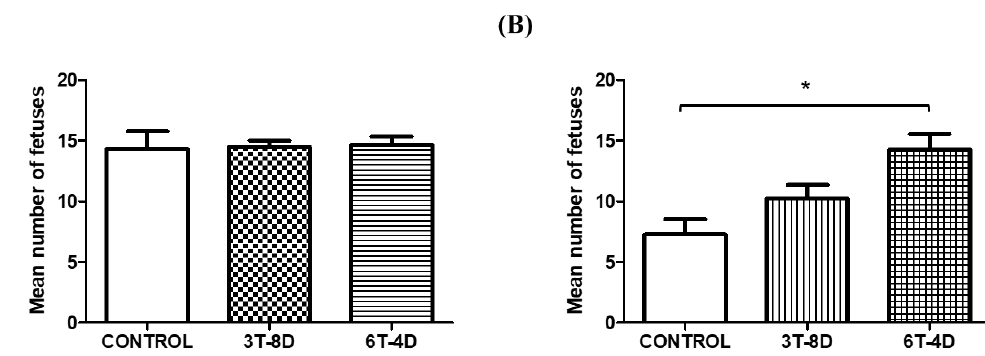
Figure 4. Assessment of fetus implantation after natural mating from control and groups of human adipose-derived stem cell conditioned medium (ASC-CM) intravenous injection in ( A ) 4-month-old and ( B ) 6-month-old mice. Data are expressed as the mean ± standard error of the mean (SEM). * p < 0.05. 4D-6T, six times injection in four day intervals; 8D-3T, three times injection in eight day intervals.